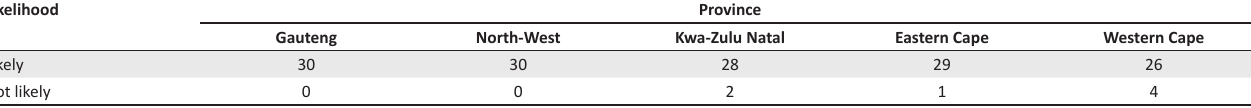
TABLE 1 : Chart displaying educators’ responses on the likelihood of disasters occurring in South Africa.